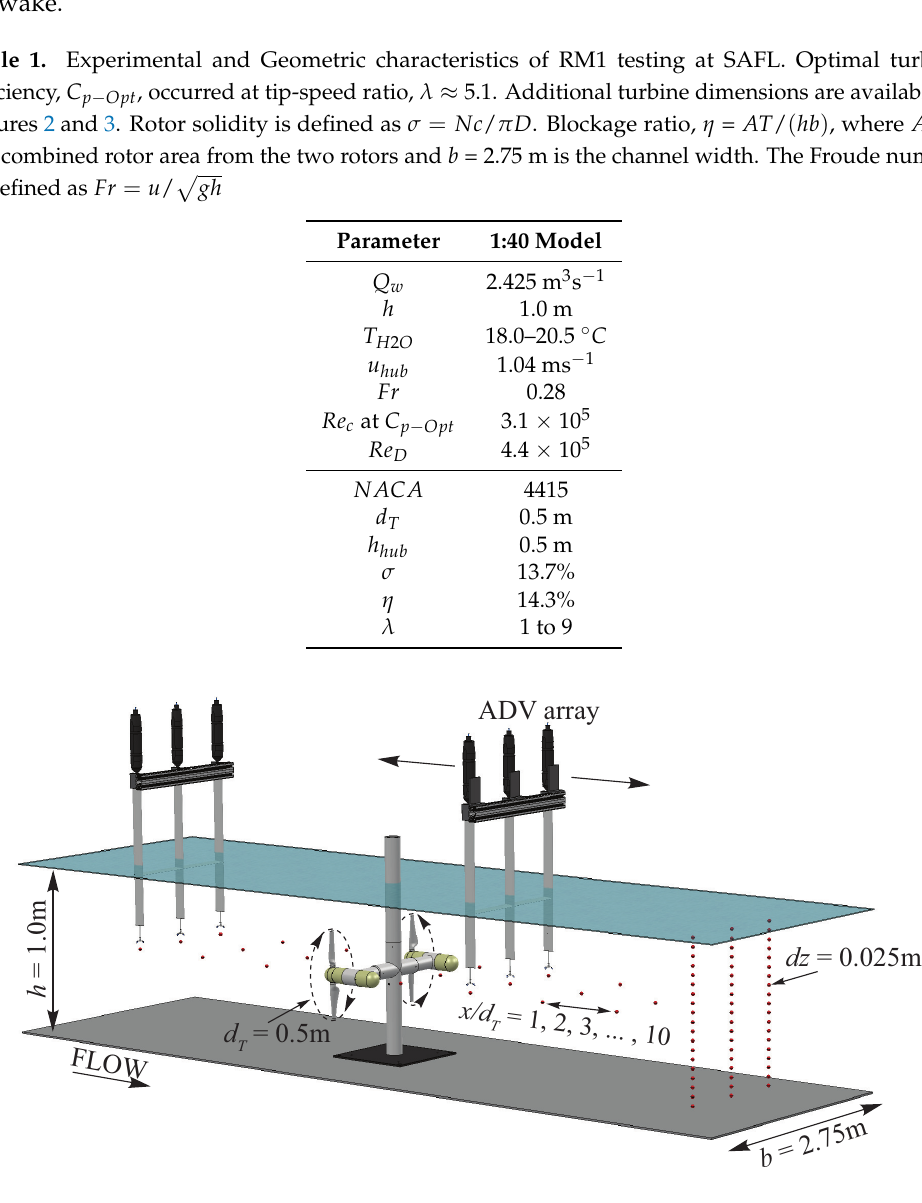
Table 1. Experimental and Geometric characteristics of RM1 testing at SAFL. Optimal turbine